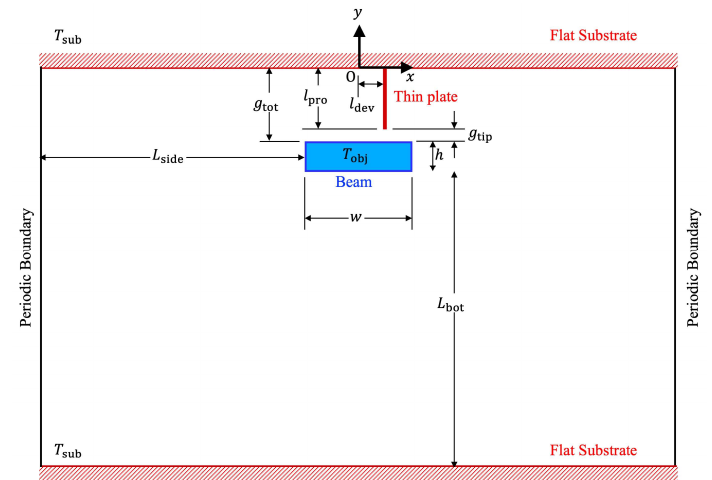
Figure 1. Schematic of the computational domain. Here, the x axis is set rightward and the y axis is set upward such that x = 0 is colinear with the center of the beam, and such that y = 0 is on the bottom surface of the upper substrate, i.e., the uppermost boundary. Furthermore, the computational domain is considered to be periodic in the − x and + x directions, and the bottommost boundary is considered to be a surface of the lower substrate. As shown in Figure 1, the distances between the left side of the computational domain and the left side of the beam and between the right side of the computational domain and the right side of the beam are both L side . The distance between the bottom surface of the beam and the bottommost boundary